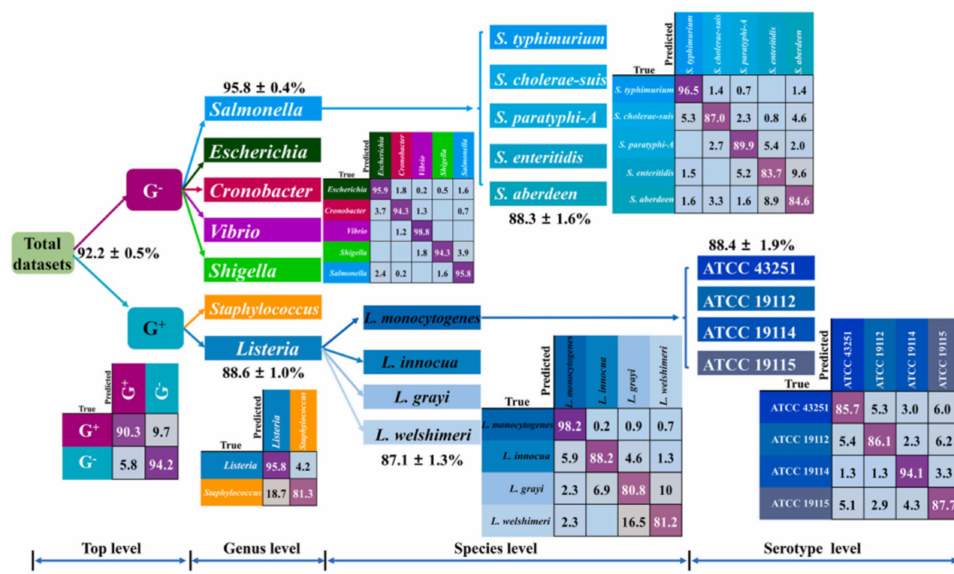
Figure 3. Rapid identification of bacteria by Raman spectroscopy and machine learning. Prediction results of independent test sets through 4-level KPCA-DT classification model. KPCA-DT Kernel principal component analysis decision tree. Reprinted from reference [36] with